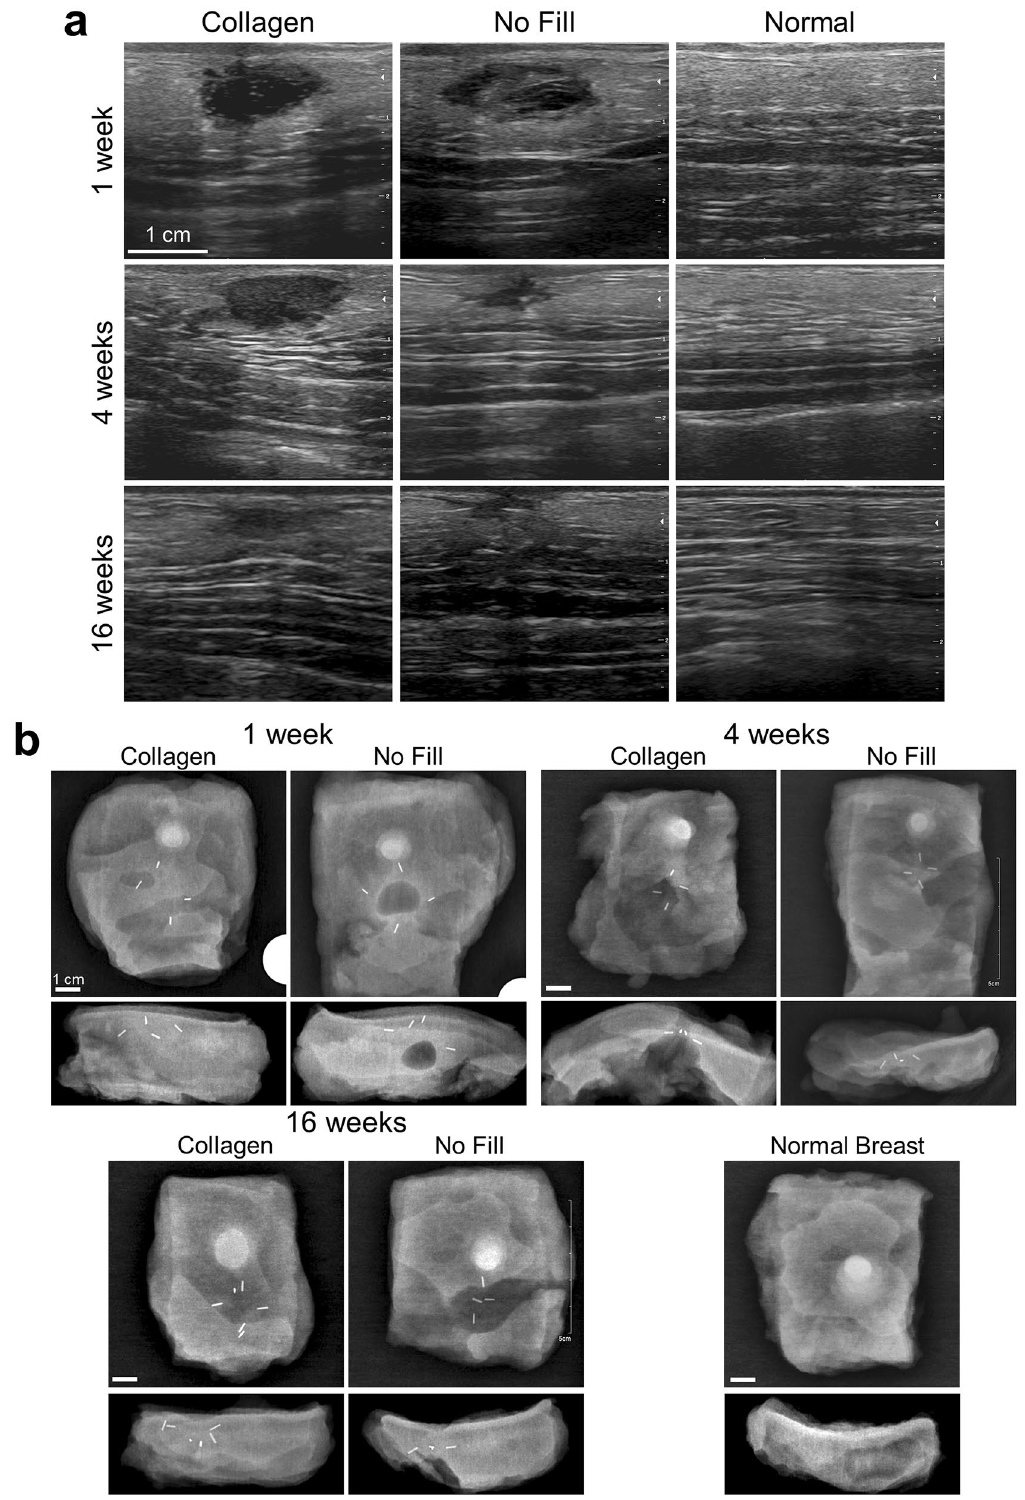
Figure 5. Collagen filler does not interfere with radiography or ultrasonography. Representative ( a ) ultrasound images and ( b ) radiographs of surgical voids treated with collagen or no fill compared to normal breast tissue at 1-week, 4-week, and 16-week time points. Radiopaque marker clips evident within radiographs indicate boundaries of surgical void and show evidence of contraction for no fill